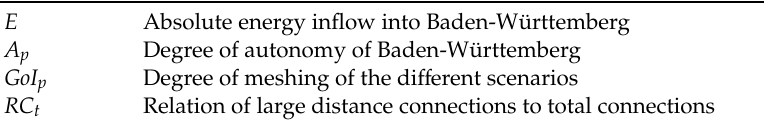
Table 4. Summary of key